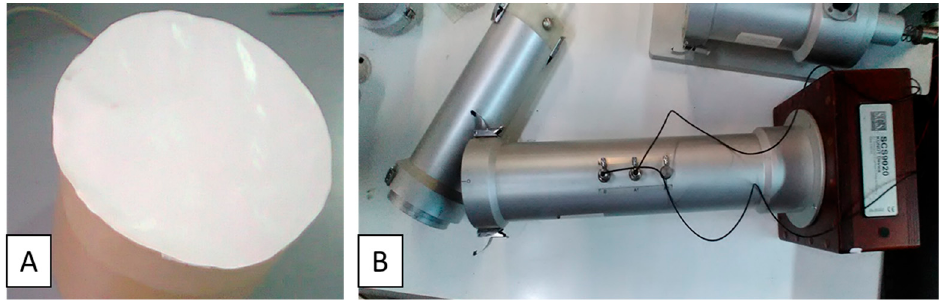
Figure 6. ( A ) Sampled used for the acoustic measurements. ( B ) Impedance tube. Table 2. Sound absorption coefficient of the sheeting, installed at a distance from the rigid wall of 70 mm.